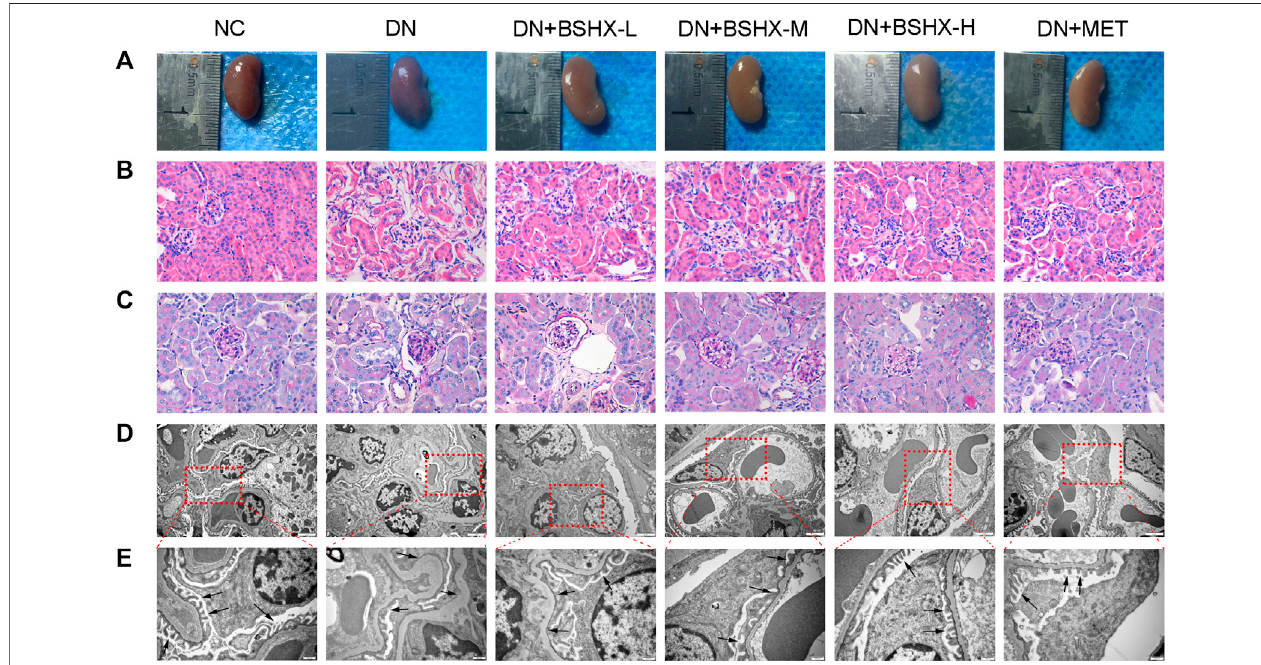
FIGURE 2 | BSHX alleviates renal histopathology and ultrastructural pathology of the kidneys. (A) Preliminary observation of the appearance and size of kidneys. (B) Hematoxylin and eosin (HE) staining of the kidney ( × 400). (C) Periodic acid Schiff (PAS) staining of the kidney ( × 400). (D) Transmission electron microscopy of the kidney (scale bar, 2 μ m). (E) Transmission electron microscopy of the kidney (scale bar, 500 nm). n (cid:1) 5 mice per group.